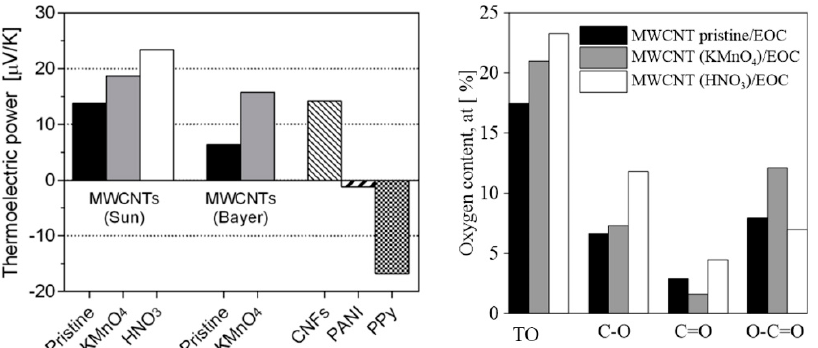
Figure 9. Thermoelectric power for tested EOC composites with indicated embedded fillers ( left panel ). Oxygen content (%) on surfaces of pristine and di ff erently oxygenated MWCNTs ( right panel ). TO denotes the total oxygen amount and the C–O, C = O, and O–C = O the amount of the particular functional groups on the surface of the respective MWCNTs.